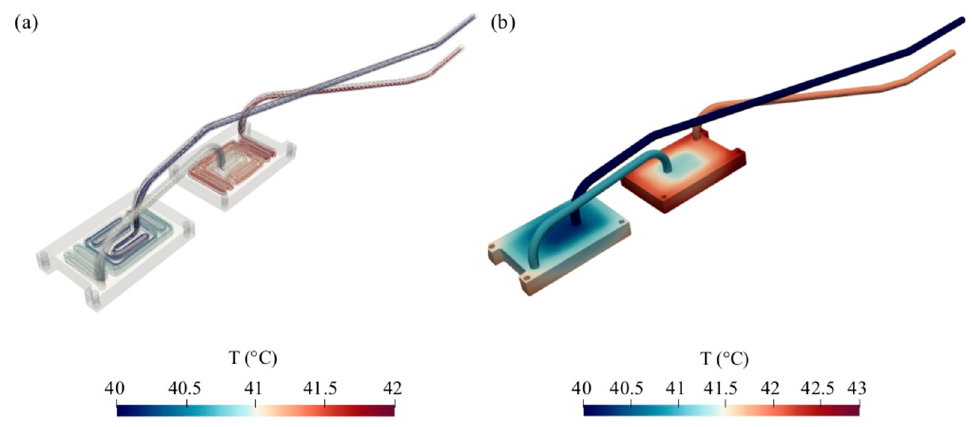
Figure 14. Temperature distributions at ( a ) water and ( b ) cold plate.